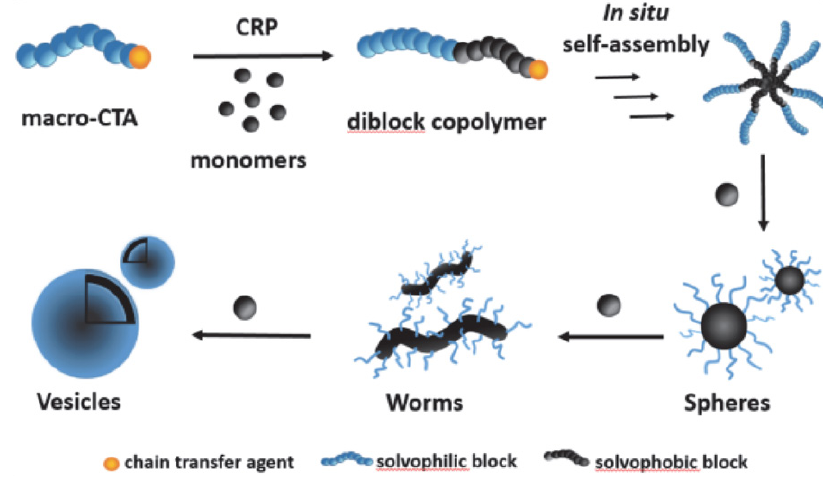
Figure 3. Polymerization induced self-assembly in water (drawn by Vikram